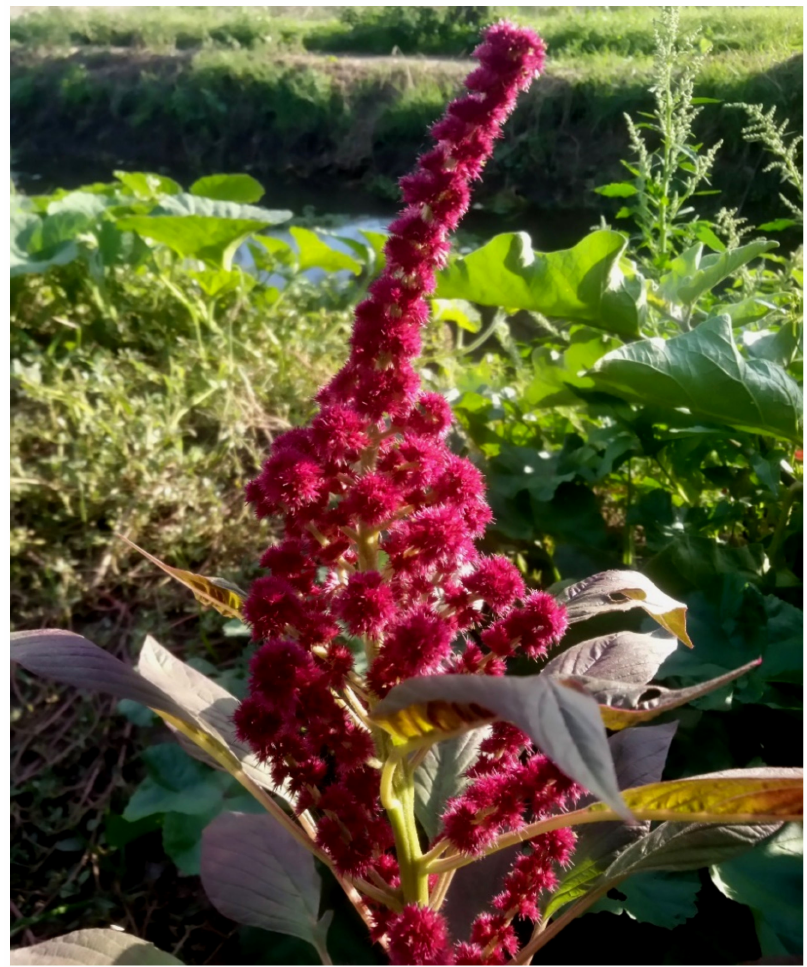
Figure 75. Amaranthus hypochondricus in Acquedotti